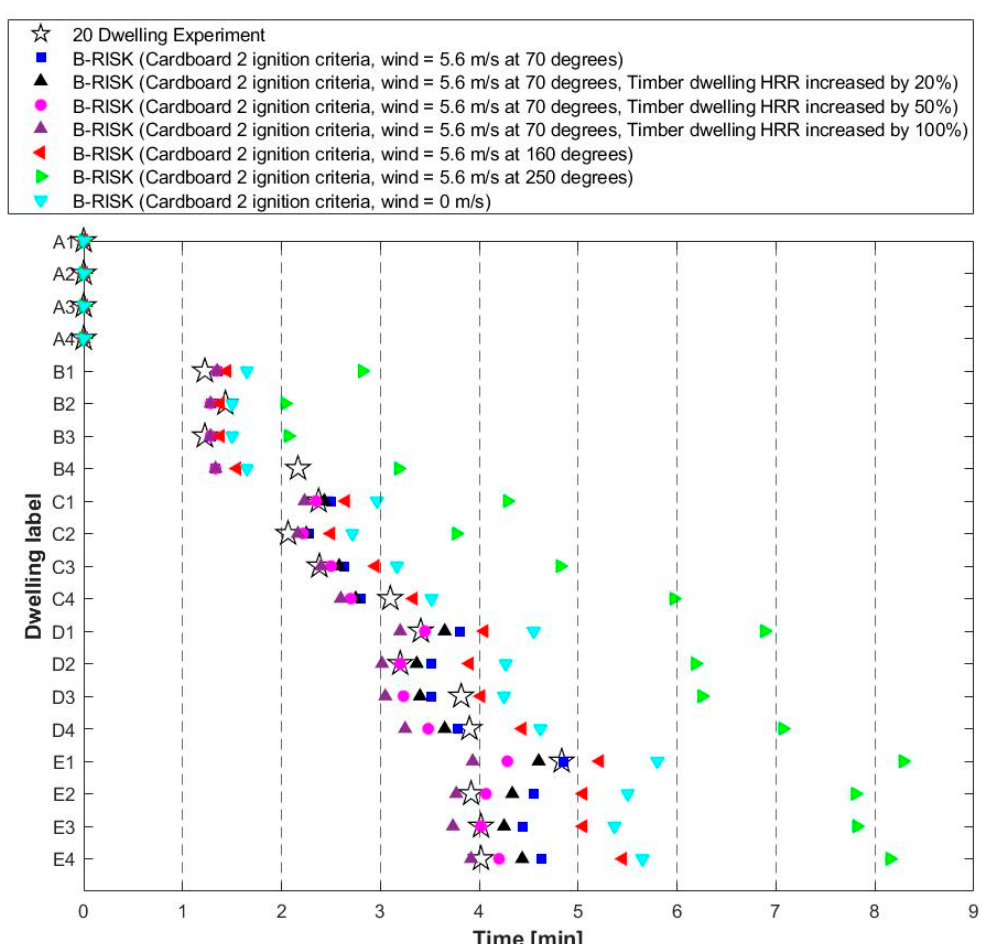
Figure 10. Experimental and simulation time-to-ignition results for the different configurations.